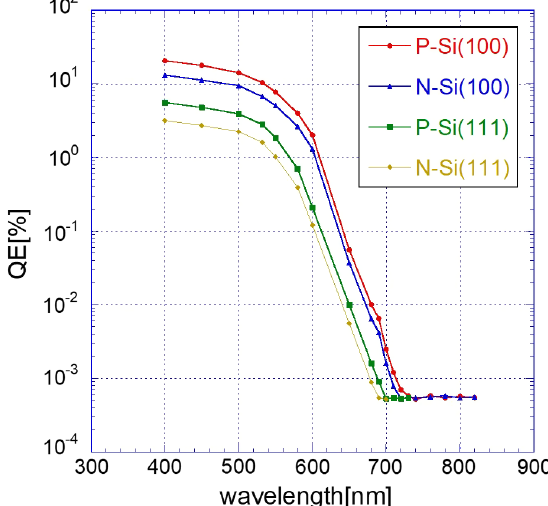
FIG. 2. Spectral response for a CsK 2 Sb photo-cathode, with red circles, blue triangles, green squares and yellow rhombuses for the p -Si(100), n -S(100), p -Si(111) and n -Si(111) substrates, respectively. The measurement limit of photocurrent is 10 nA.